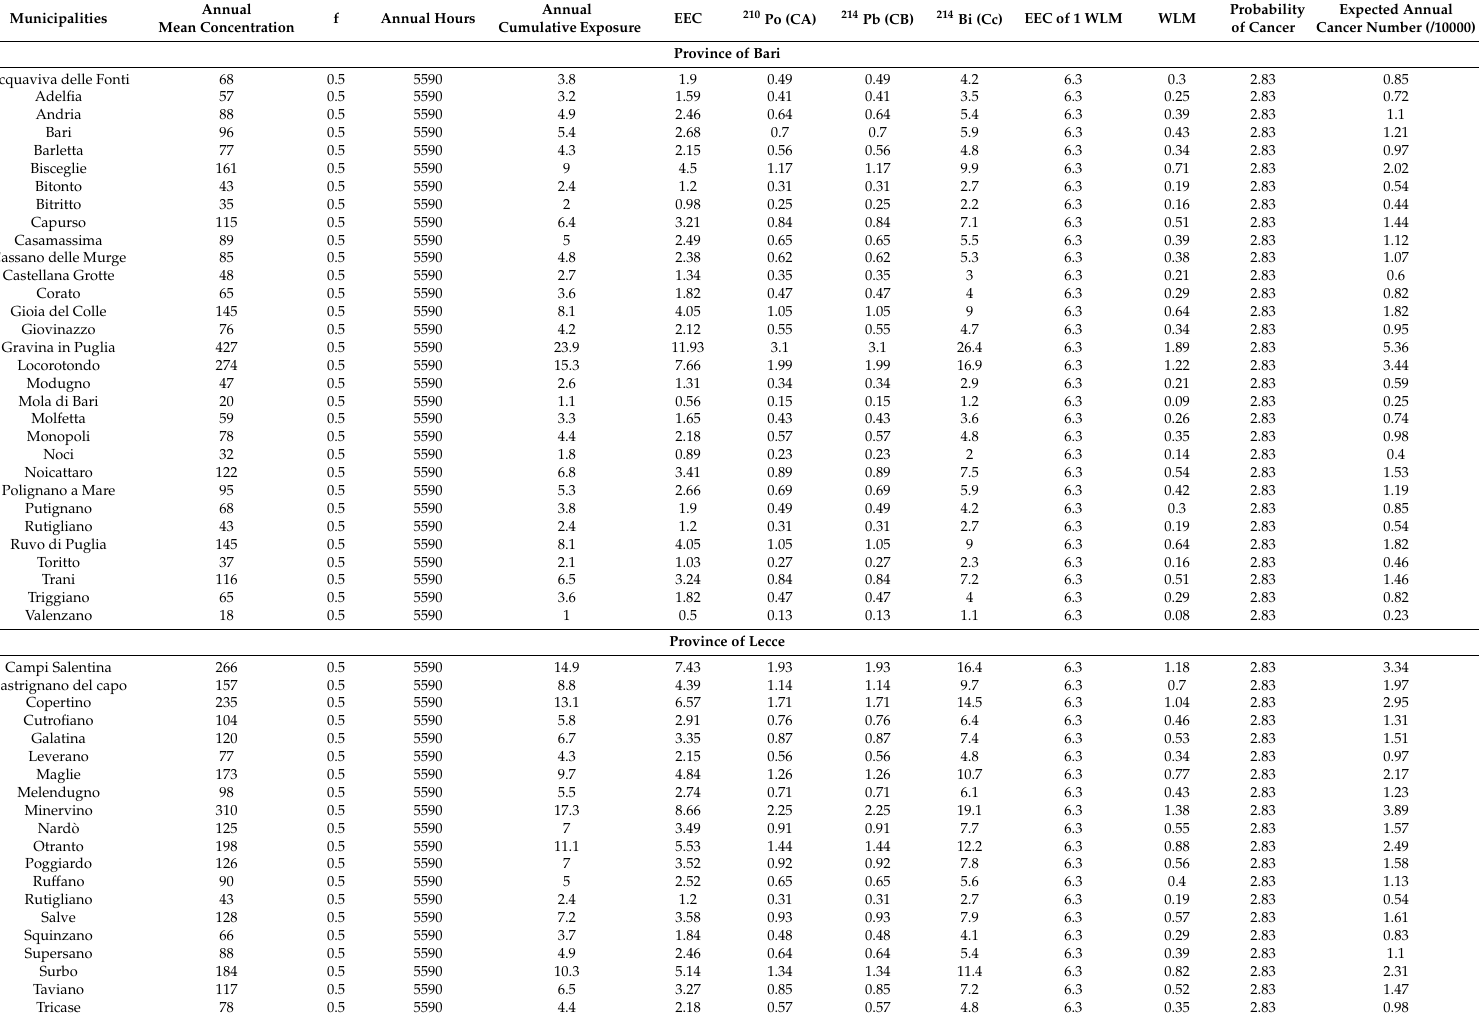
Table 3. Distributions of radon concentrations and its decay isotopes and the expected annual frequency of radon attributable lung cancer by city.